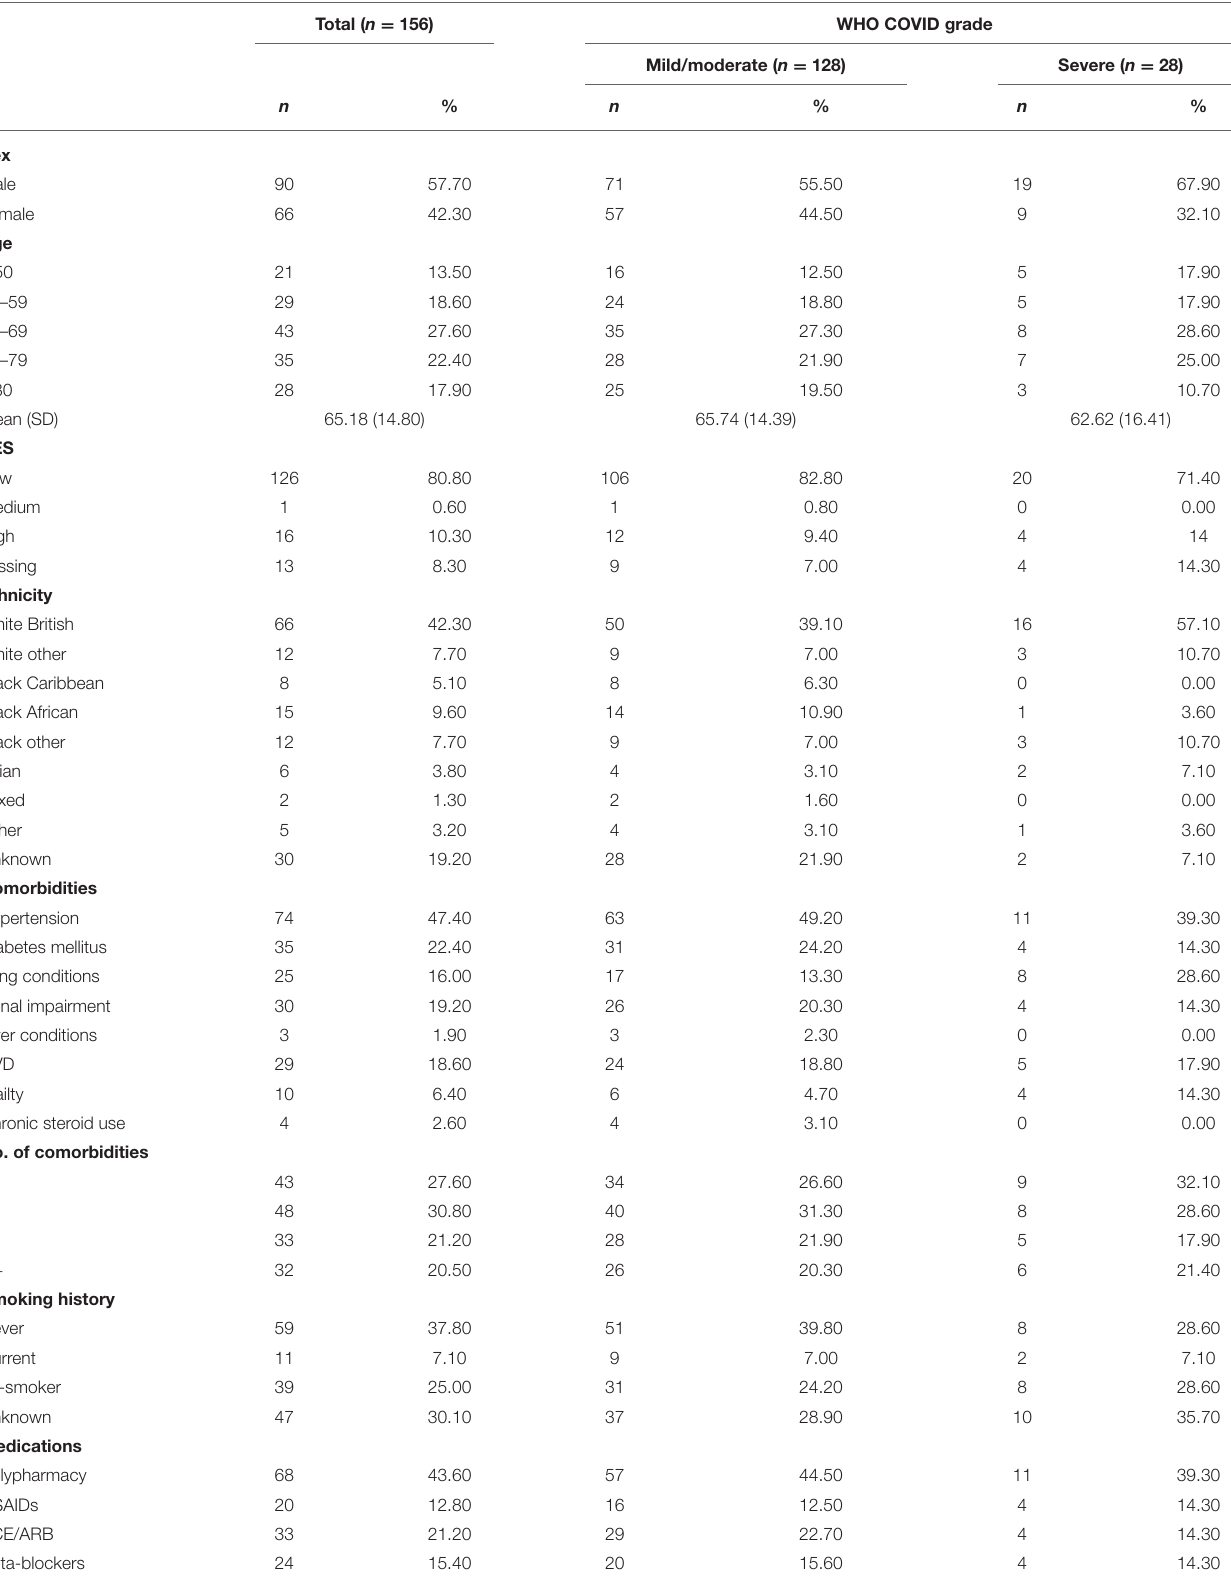
TABLE 1 | Demographic characteristics of COVID-19 positive cancer patients.